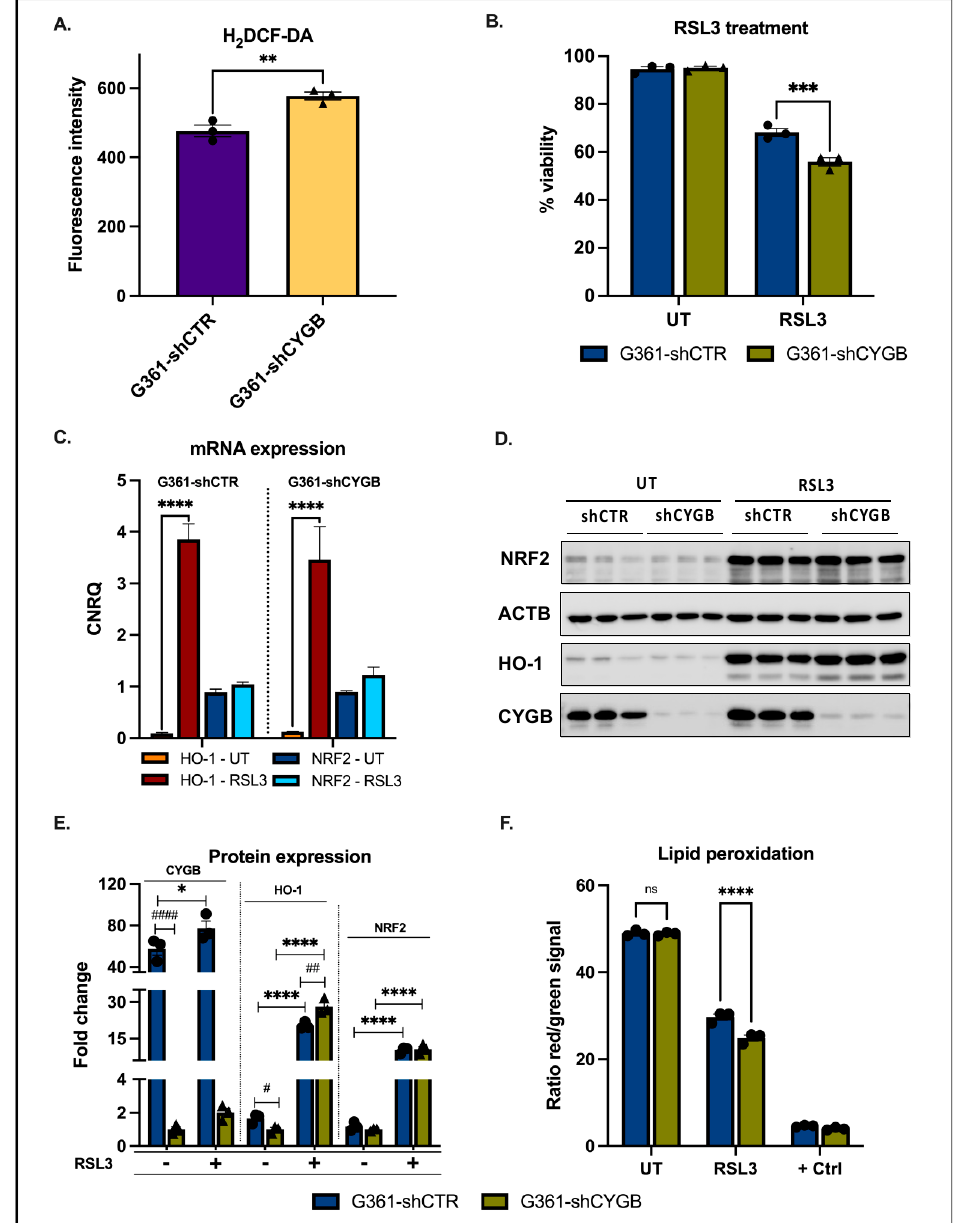
Figure 2. Cytoprotective effect of CYGB. ( A ) Knockdown of CYGB increased basal intracellular ROS levels. ( B ) G361-shCTR and G361-shCYGB cells were treated with 7.5 µ M RSL3 and cell viability was measured after 24 h using propidium iodide (PI) staining. ( C ) The average calibrated normalized relative quantities (CNRQ) of HO-1 and NRF2 mRNA under basal conditions (UT) or upon RSL3 treatment. CNRQ values were normalized to B2M and YWHAZ. ( D ) Immunoblotting results of NRF2, HO-1 and CYGB 6h after RSL3 treatment. ACTB was used as loading control. ( E ) The average fold change in protein expression of HO-1, NRF2 and CYGB in G361-shCTR and G361-shCYGB cells, compared to the untreated G361-shCYGB samples (set as 1). Measured immunoblot signals were normalized to the loading control ACTB. ( F ) Average ratio of the measured red (reduced) over green (oxidized) signal of the BODIPY 581/591 C11 reagent in G361-shCTR and G361-shCYGB cells. Cells were either untreated or treated with 7.5 µ M RSL3 or 100 µ M cumene hydroperoxide (positive control). All results are depicted as the mean with S.E.M. of three independent experiments (n = 3). ( A ) Student’s t -test (** p ≤ 0.01), ( B – F ) two-way ANOVA (* /# p ≤ 0.05; ** /## p ≤ 0.01; *** p ≤